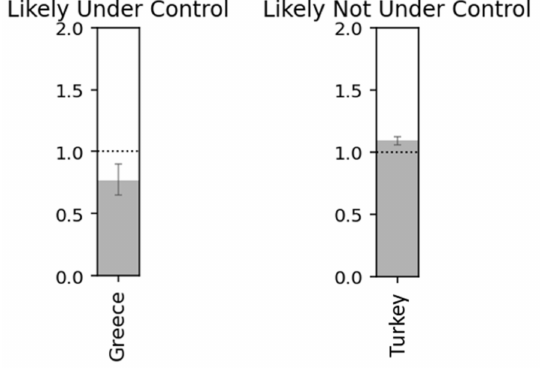
Figure 24. Countries R t with under and not under control.